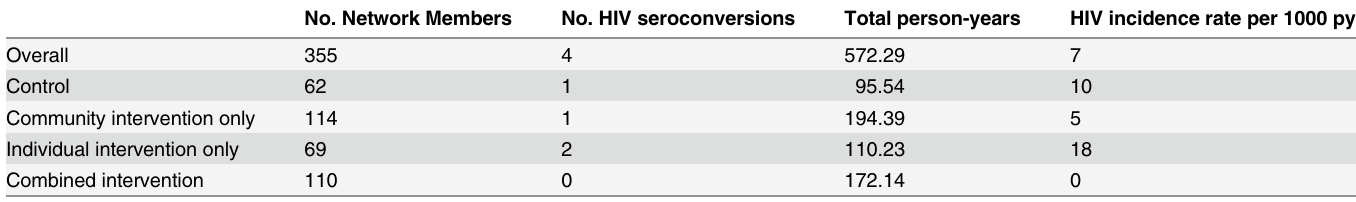
Table 2. HIV incidence overall and by